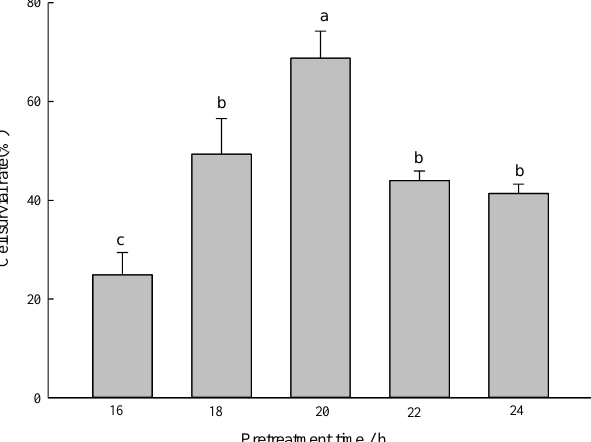
Figure 3. Effect of preculture time on the cell survival percentage of F. mandshurica embryonic callus after cryopreservation by the slow cooling method. Note: Lowercase letters represent significant differences at p < 0.05.